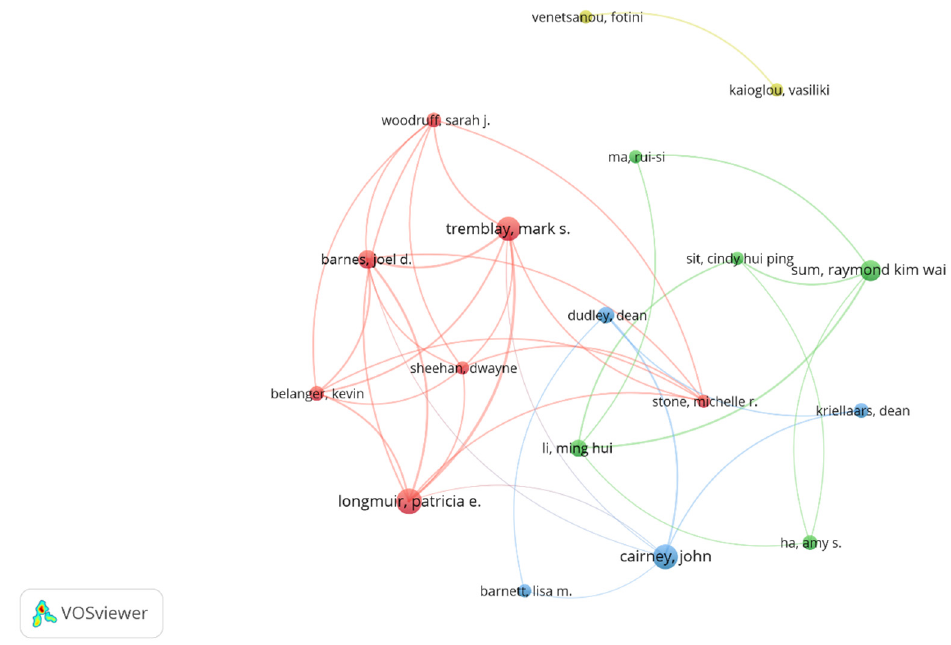
Figure 2. Prolific co-authors. Figure 2. Proli fi c co-authors. Table 3. Prolific Table 3. Proli fi c co-authors.